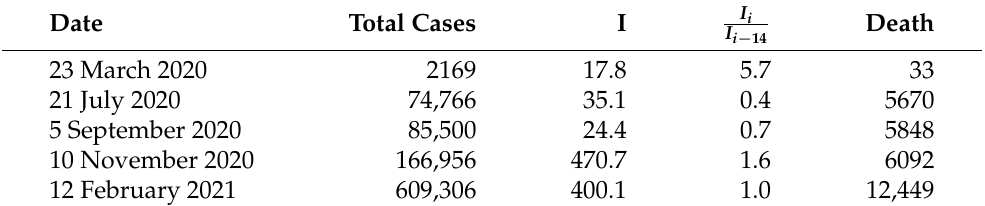
Table 3. Data for Sweden: Total cases, Cases per 100,000 inhabitants in the last 14 days, rate of Cases in the last 14 days and the previous 14 days interval, Death related to